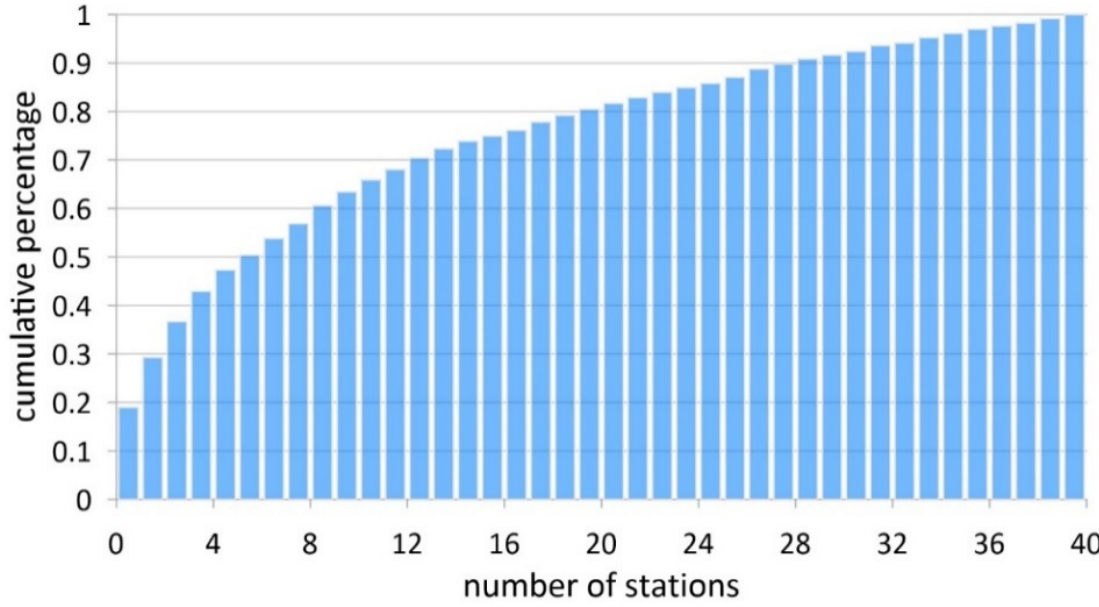
Figure 5. Cumulative relative frequencies of hot days in Poland in the period 1951–2019 observed simultaneously at given number of stations.